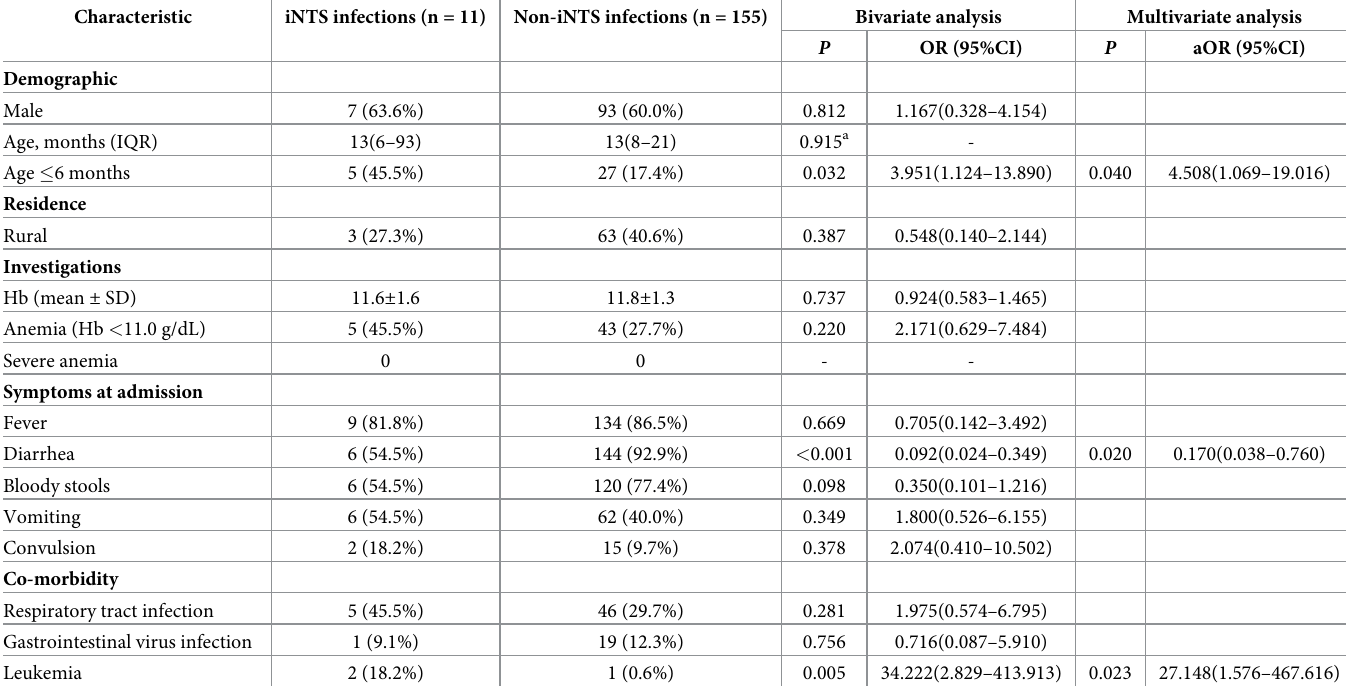
Table 2. Demographic, residential and clinical manifestations of children with NTS infections, Ningbo, China, 2012–2019. Characteristic iNTS infections (n = 11) Non-iNTS infections (n = 155) Bivariate analysis Multivariate